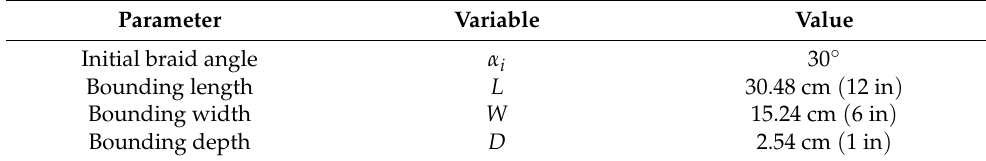
Table 1. System parameters.